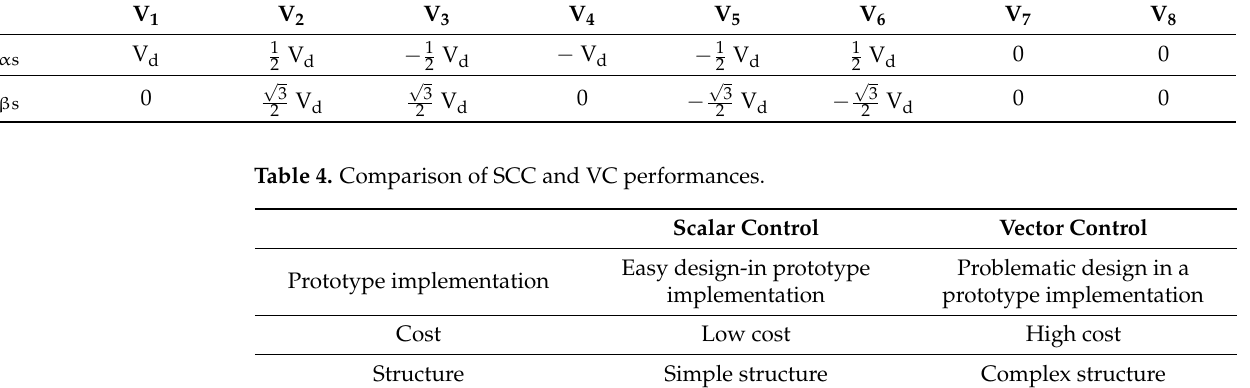
Table 3. Stationary ( α - β ) stator voltages.